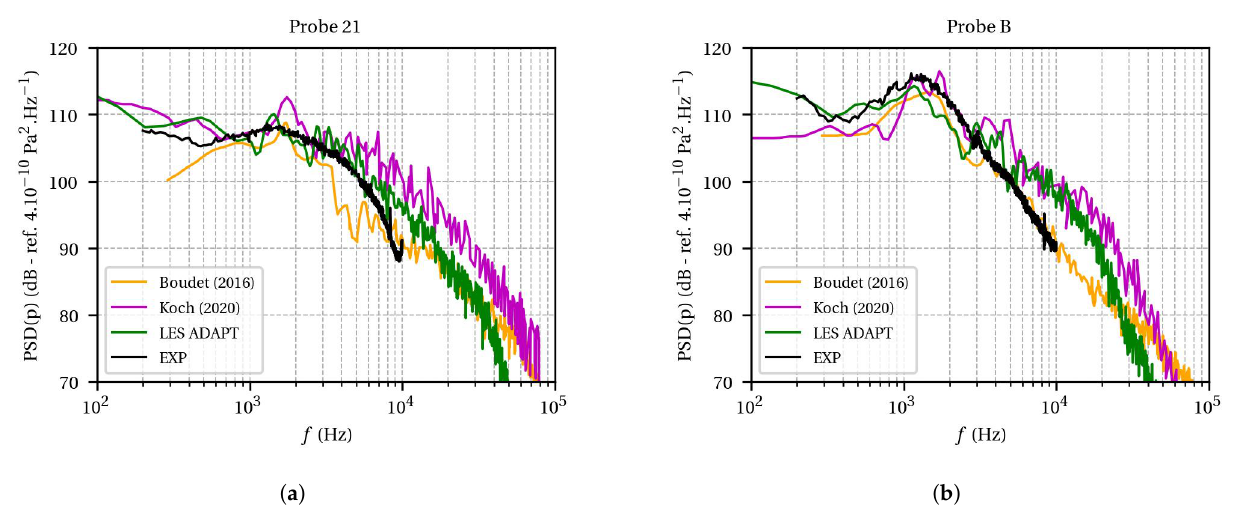
Figure 13. PSD of the wall pressure on the airfoil suction side ( a ) and on the airfoil tip ( b ) at 77.5% of the